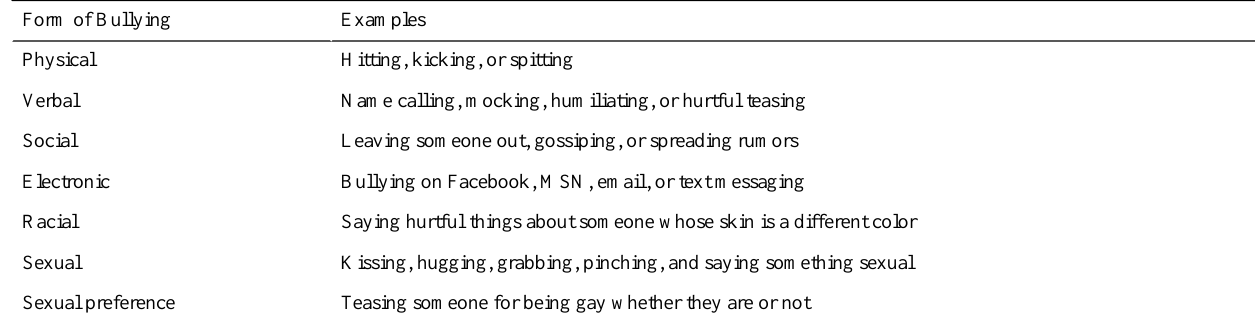
Table 1. Forms of bullying and examples provided to respondents.